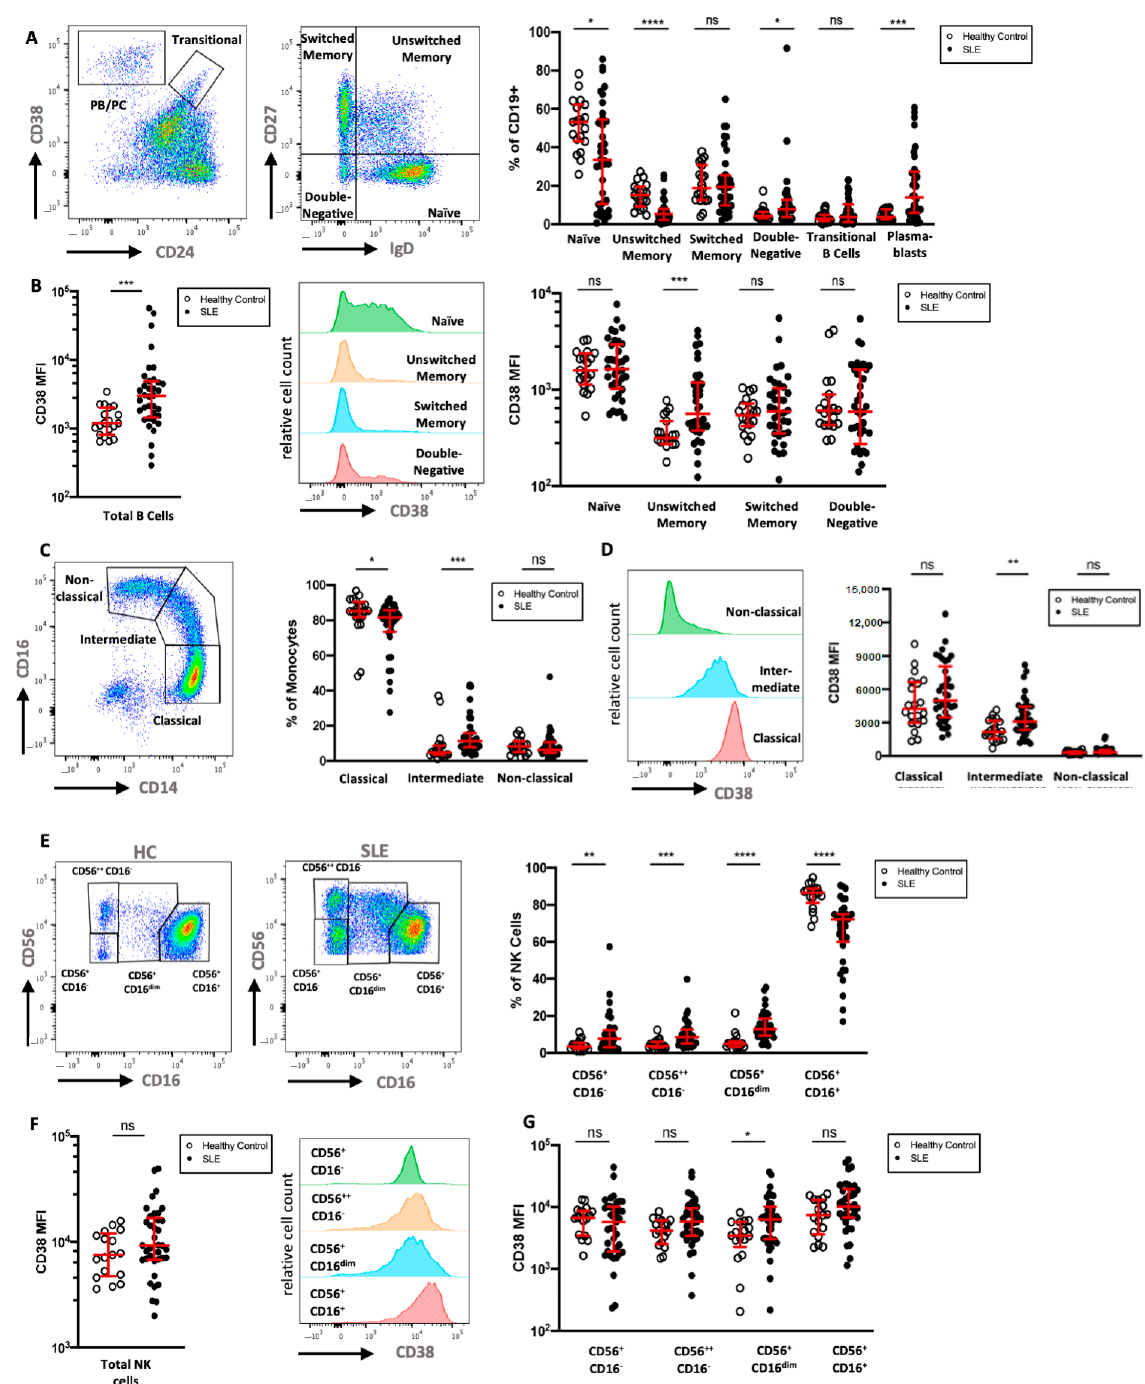
Figure 4. Flow cytometric analysis of CD38 expression in B cells, monocytes, and NK cells ( A ) Gating of CD19 + B cells in a HC, with separation of plasmablasts (CD24 − CD38 ++ ) and transitional B cells (CD24 ++ CD38 ++ ). B cells that were neither plasmablasts nor transitional B cells were divided into naive (IgD + CD27 − ), unswitched memory (IgD + CD27 + ), switched memory (IgD − CD27 + ), and double-negative B cells (IgD − CD27 − ). Relative frequencies of B cell subsets in 36 SLE patients and 19 HC are shown. ( B ) Comparison of CD38 expression on all B cells and on the previously defined B cell subsets in SLE and HC. ( C ) Gating and relative frequencies of classical (CD14 ++ CD16 − ), intermediate (CD14 ++ CD16 + ), and non-classical (CD14 + CD16 ++ ) monocytes. ( D ) CD38 expression on monocyte subsets in a representative HC and comparison of CD38 expression on monocyte subsets between HC and SLE patients ( E ). Representative gating of CD56 + CD3 − NK cell subsets into four subsets in one HC and one SLE patient. ( F , G ) Comparison of CD38 expression on all NK cells and on the previously defined NK cell subsets. Mann–Whitney test of 19 HCs and 36 SLE patients. ns, not significant, p >= 0.05; * p < 0.05; ** p < 0.01; *** p < 0.001; **** p < 0.0001; MFI: median fluorescence